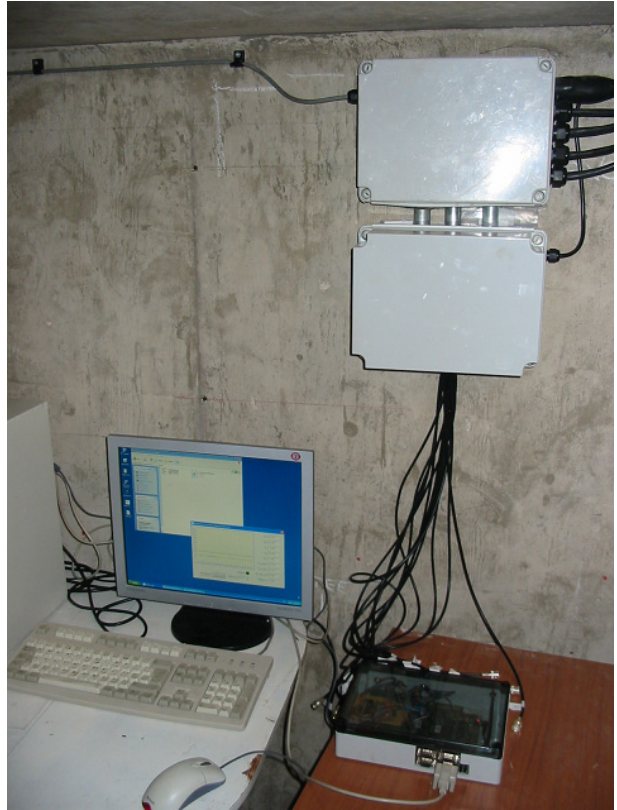
Figure 14. Device implementation in IP67 enclosure (bottom right), interface to local PC (bottom left) and instrumentation/communication interfaces (top right).